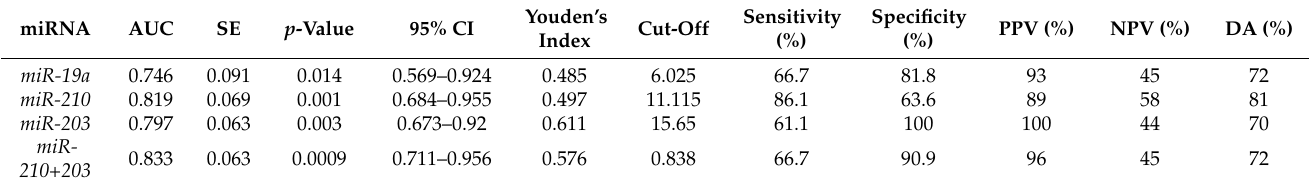
Table 3. Diagnostic parameters to evaluate individual and combined miRNA for liver metastasis in CRC patients. AUC: area under the curve, SE: standard error of mean, PPV: positive predicted value, NPV: negative predicted value, and DA: diagnostic